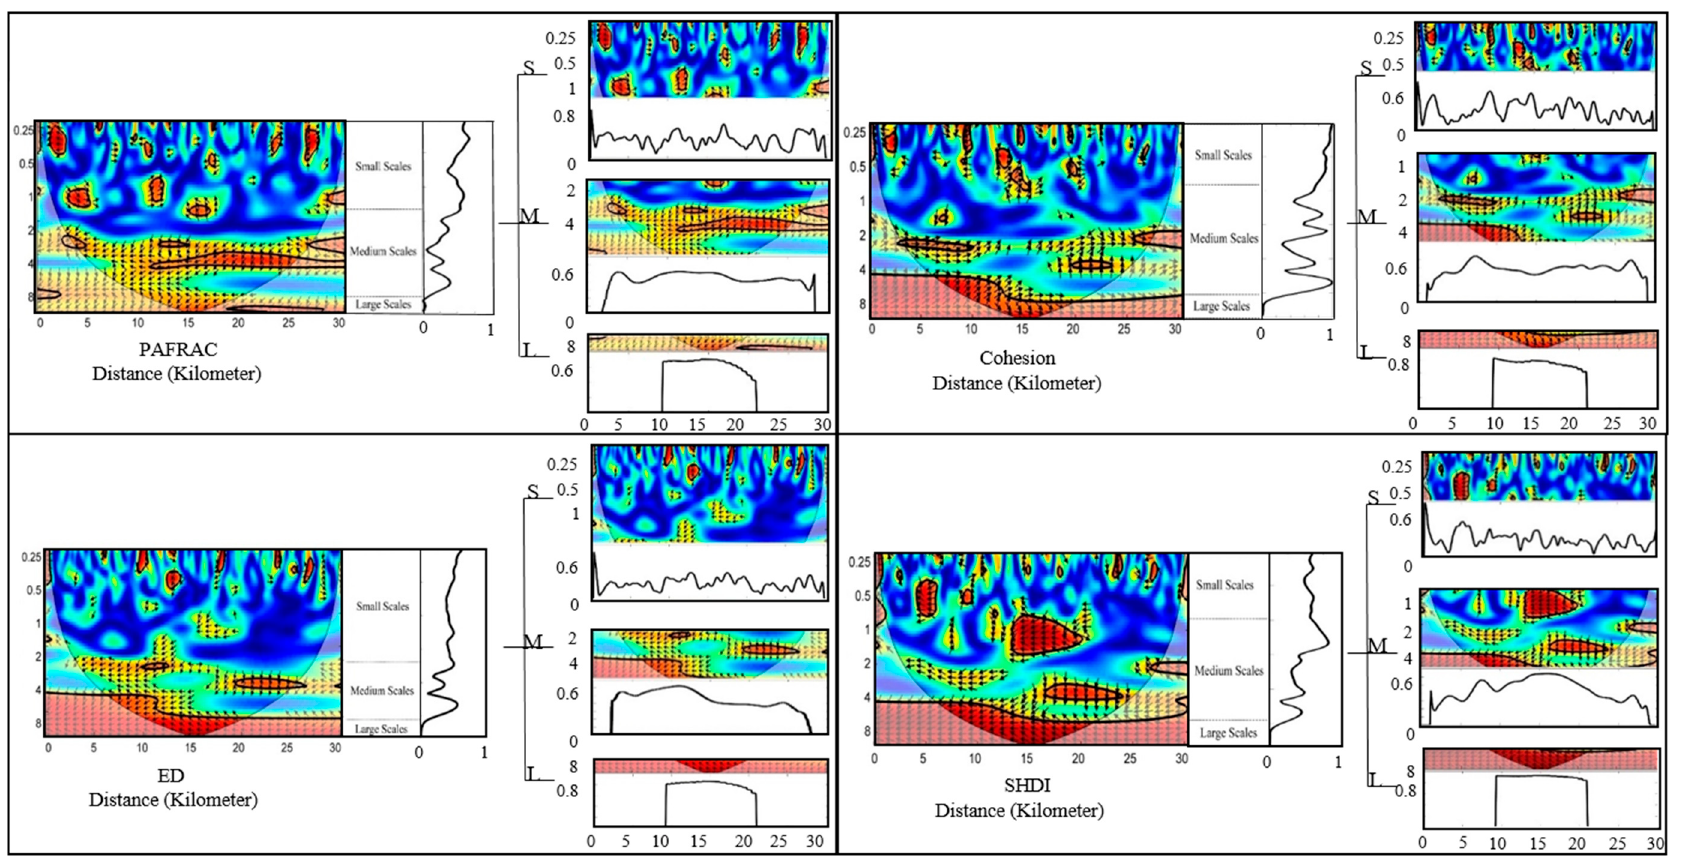
Figure 4. The wavelet coherencies between landscape indices and elevation in profile A. The capital letters S, M, and L represent small, medium, and large scales, respectively. The figures on their left represent the wavelet coherencies and standard deviation curves. The captions describe the relative scale intervals. The figures to the right of the letters represent the wavelet diagrams and average correlation-location curves corresponding to small scales, medium scales, and large scales from top to bottom.